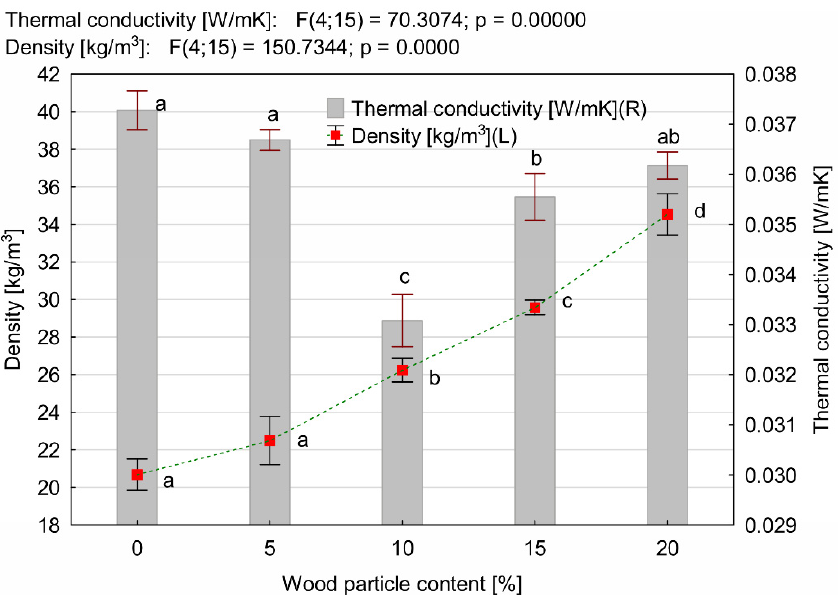
Figure 6. Thermal conductivity and density of PUR-WP composition depending on wood particle content. Different letters indicate homogeneous groups of mean values determined by one-factor ANOVA with Tukey’s test.